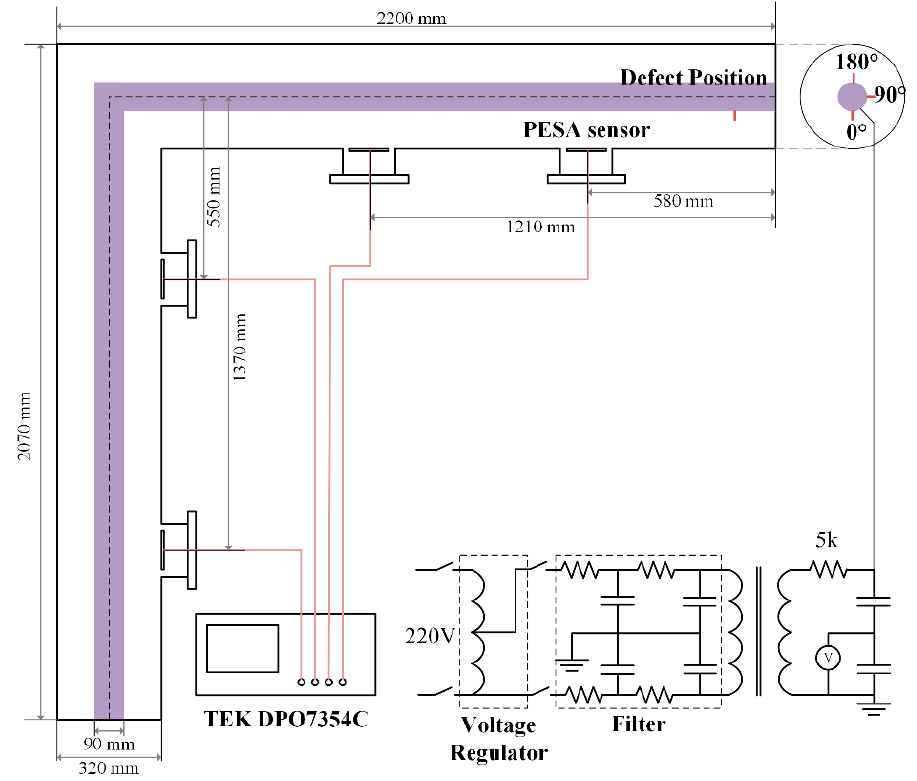
Figure 8. Schematic diagram of the GIS tank, PESA sensors, and the experimental circuit.